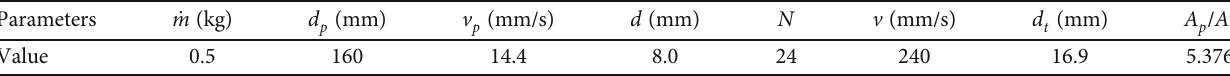
Table 2: Parameters used in the experiment.